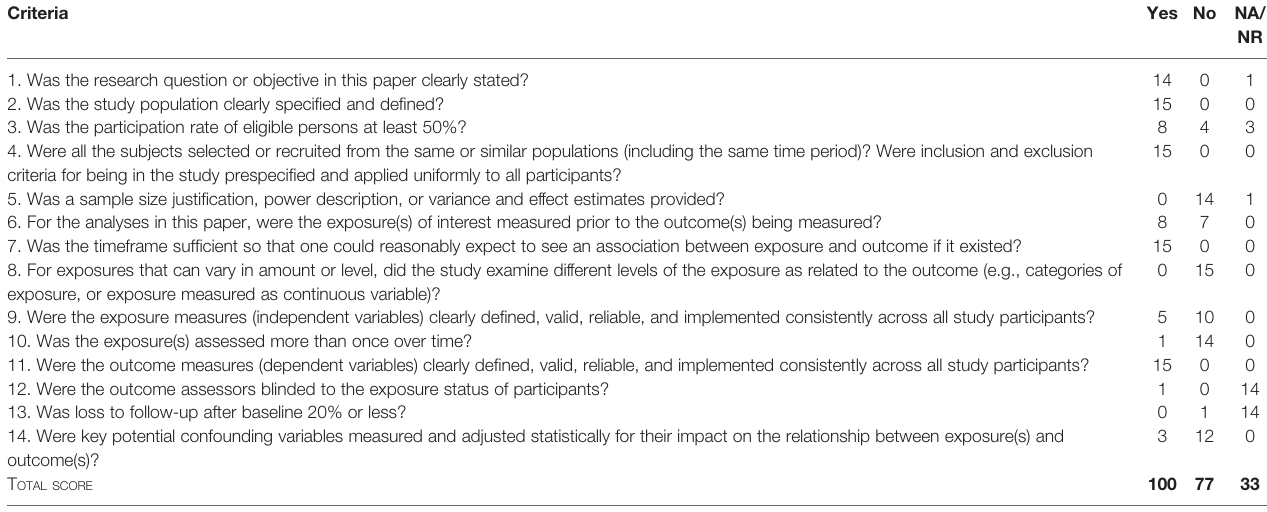
TABLE 4 | Assessment of risk of bias ( N =